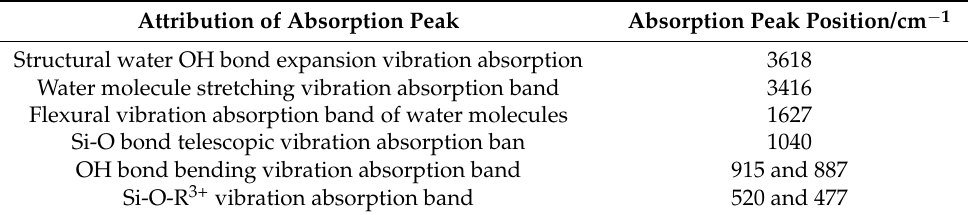
Table 2. Fundamental frequency vibration and main absorption peaks of infrared spectral activity of sodium